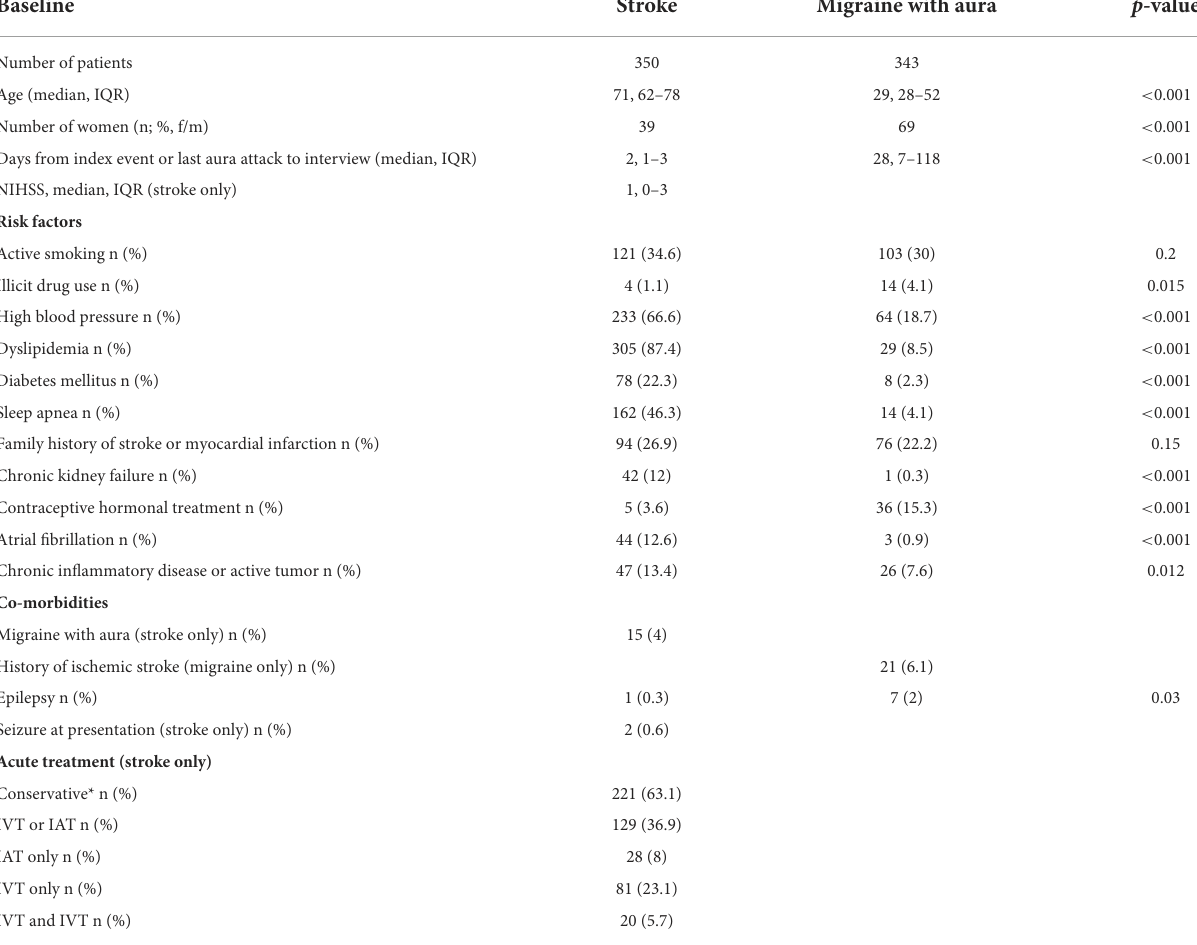
TABLE 1 Baseline characteristics and risk factors for stroke in migraine with aura and stroke groups. Baseline Stroke Migraine with aura p